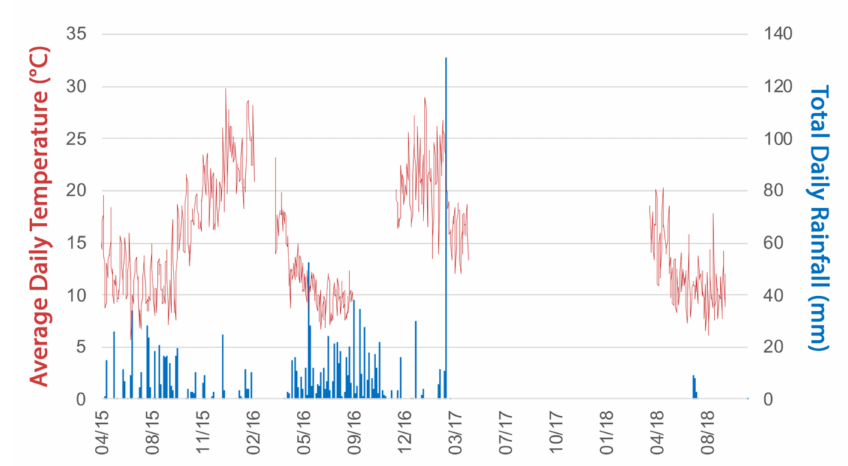
Figure 1. Average daily temperature ( ◦ C) and rainfall (mm) of Silky Oak and Redwood sites. Where the temperature line is discontinuous, data are missing for rainfall also, except September to November